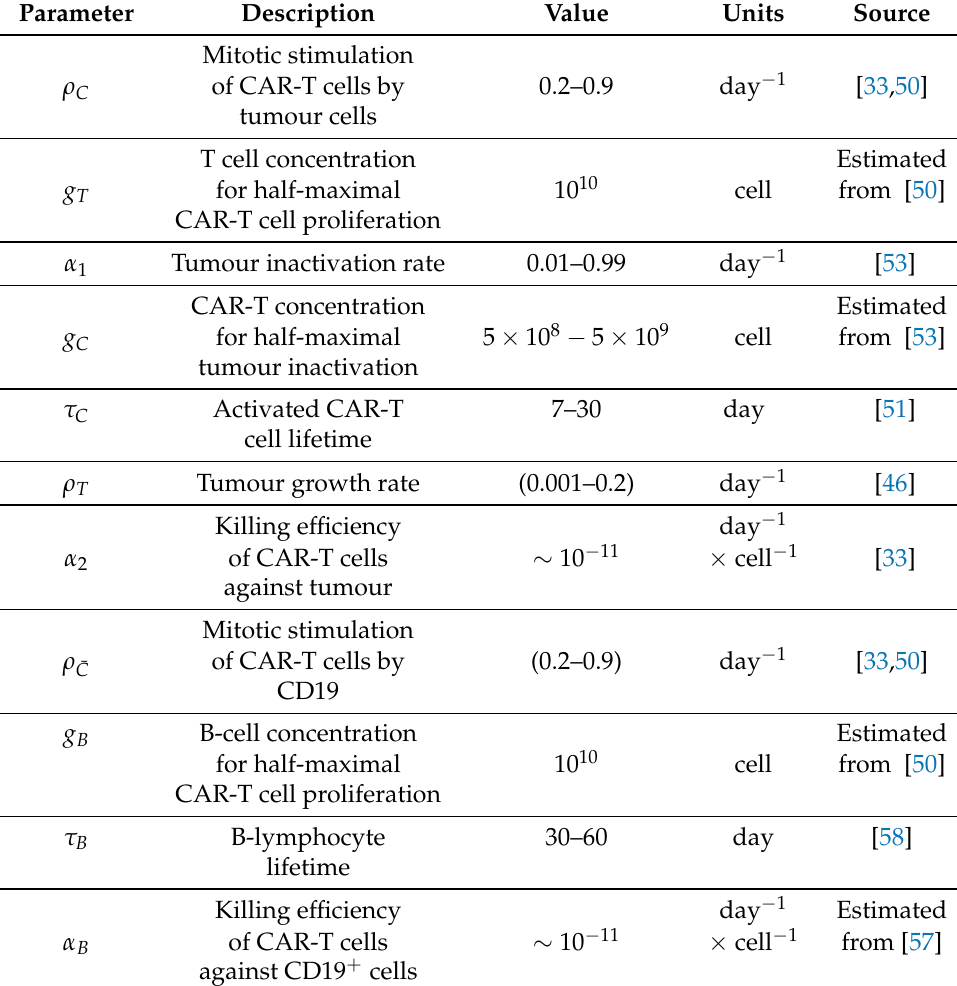
Table 1. Parameter values for the Equations